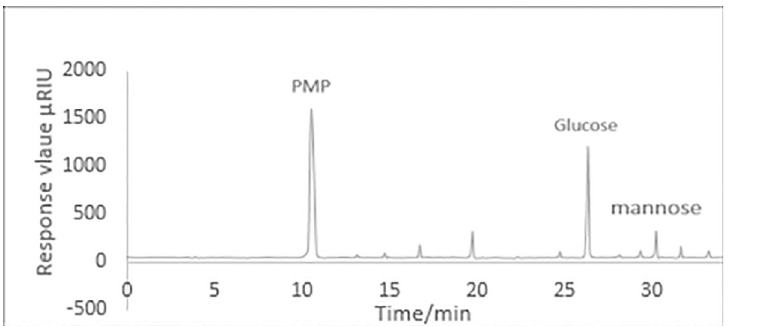
Fig 12. HPLC chromatogram of the MYH-2 hydrolysate.